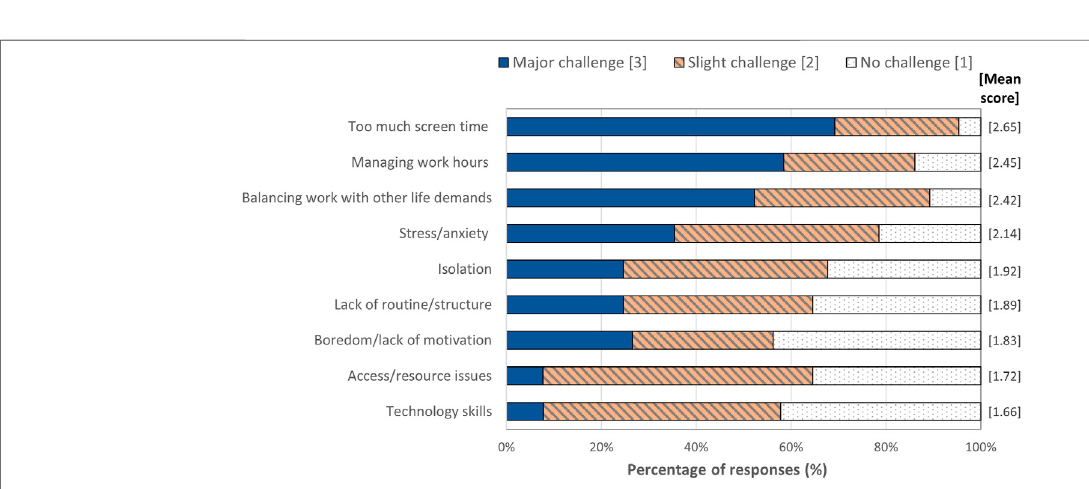
FIGURE 2 | Challenges experienced while working from home, during the initial